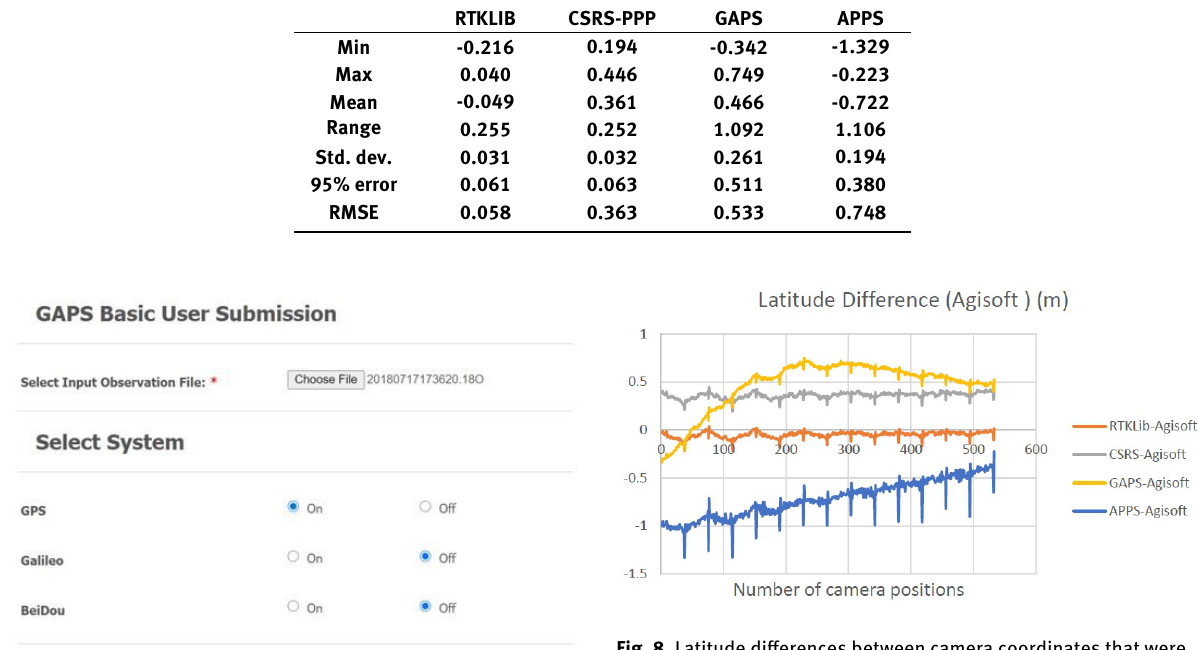
was the largest among all the software used, which indi- cated the lowest accuracy.